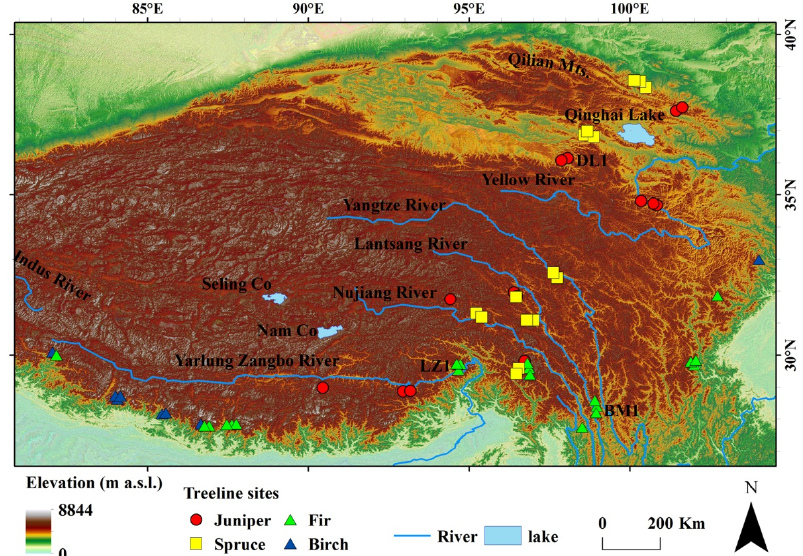
Figure 1. Map showing the geographical location of treeline sites and the four different tree species forming the treelines on the Tibetan Plateau. The site codes (DL1, LZ1, BM1) indicate the location of sites with in situ climate data taken near treeline sites.